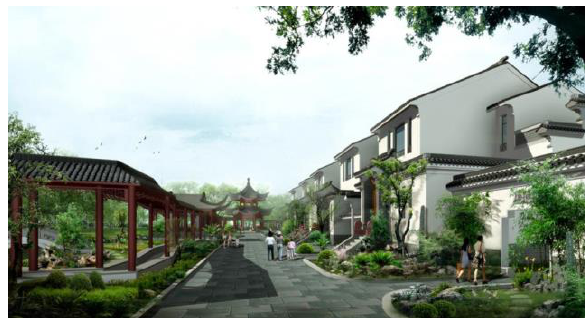
Figure 17. Model of Suzhou Fuyuan courtyard garden villa estate, Suzhou 7th Housing Exhibition. Photo: Donia Zhang 2007.